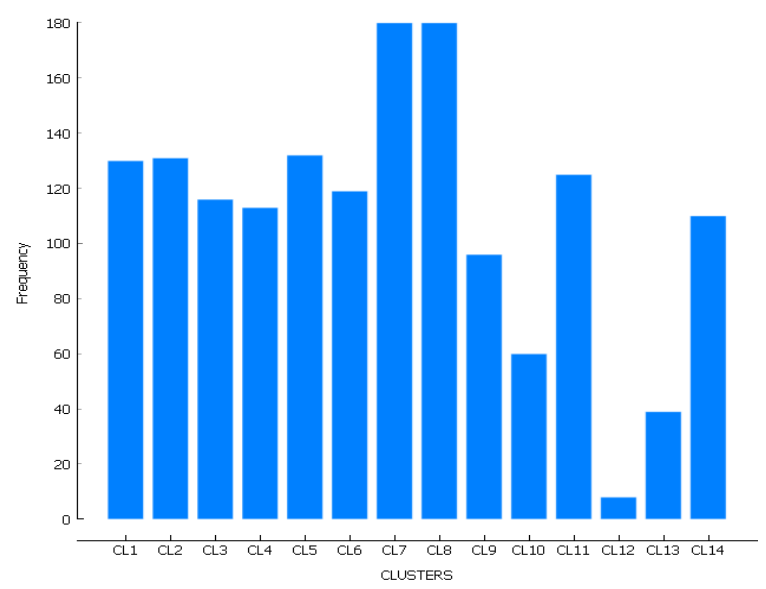
Figure 10. Crime Distribution by